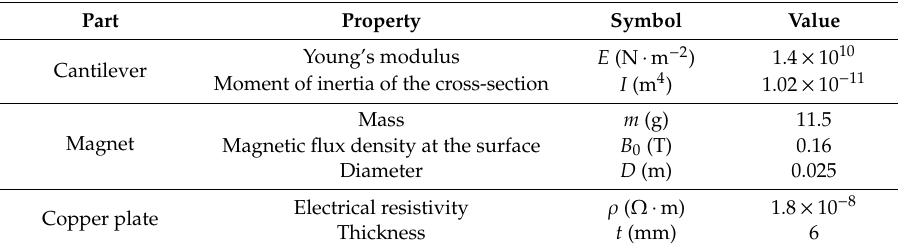
Table 1. Parameters of ECTMD.